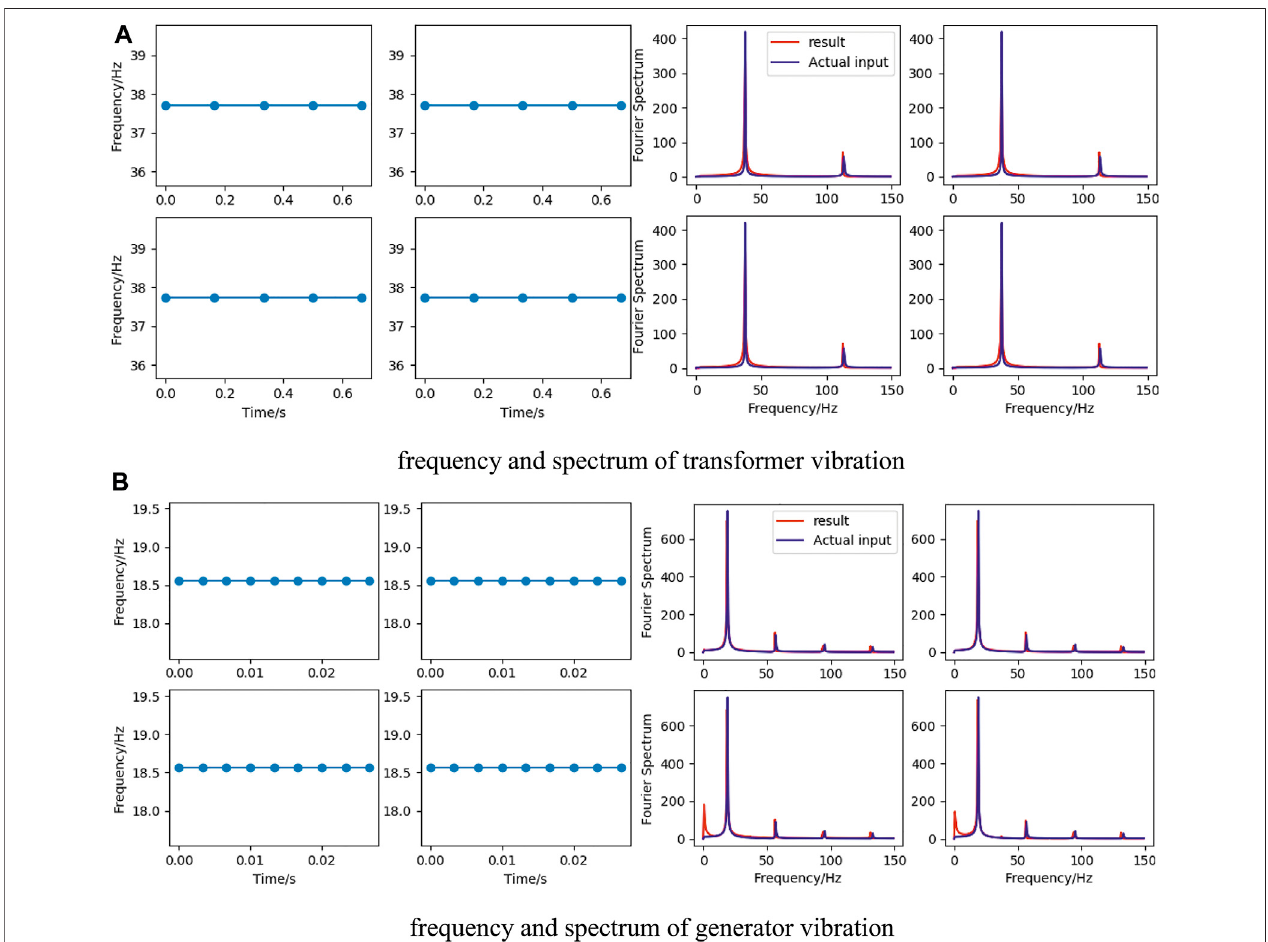
FIGURE12| Thevibrationfrequenciesoffourfeaturepoints,andcomparisonoffourfeaturepointsspectracalculatedbythearti fi ciallysetvibrationvectorsandthe proposed method. (A) frequency and spectrum of transformer vibration. (B) frequency and spectrum of generator vibration.